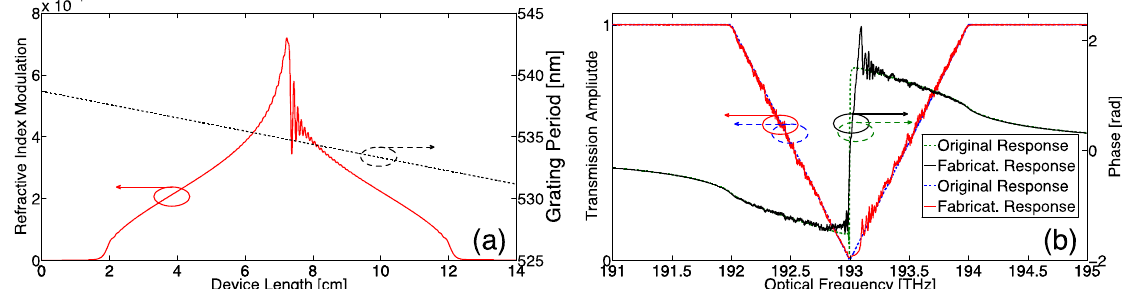
Figure 7. First-order optical differentiator based on a transmissive FBG: ( a ) Grating period (black dashed line) and apodization (red solid line) profiles considering linearly chirped phase mask and representative spatial resolution (0.3 mm); ( b ) Targeted transmission spectral response, phase (dotted green line) and amplitude (dotted blue line) and corresponding spectral response limited to fabrication constraints, in phase (solid black line) and amplitude (solid red line).